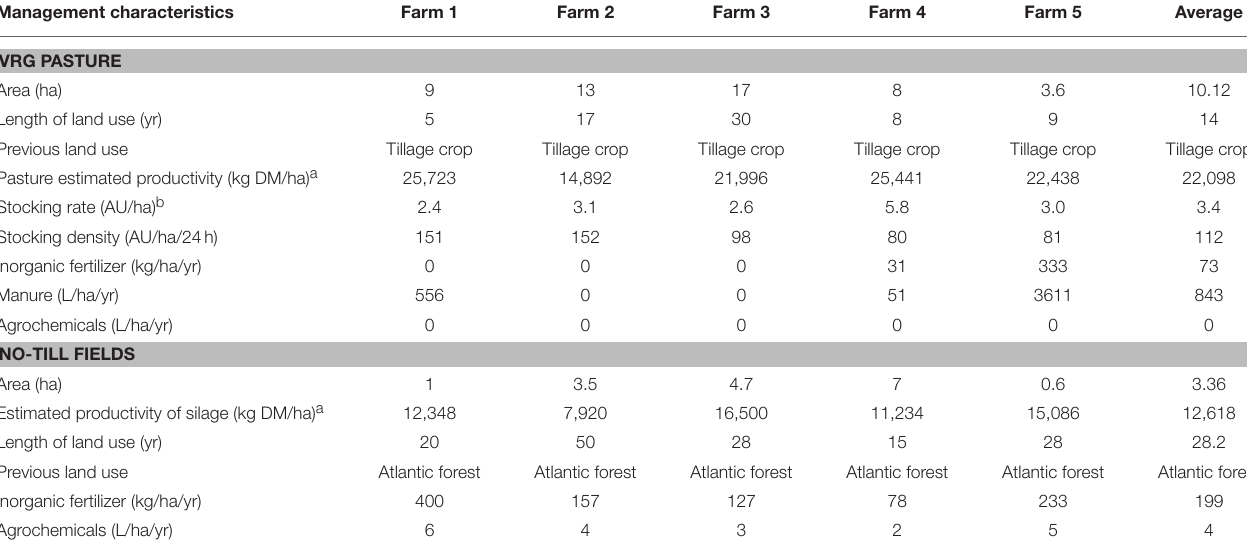
TABLE 1 | Land-use characteristics on each of the five properties studied for carbon stock in Voisin’s Rational Grazing (VRG) and No-tillage crop system (NT). Management characteristics